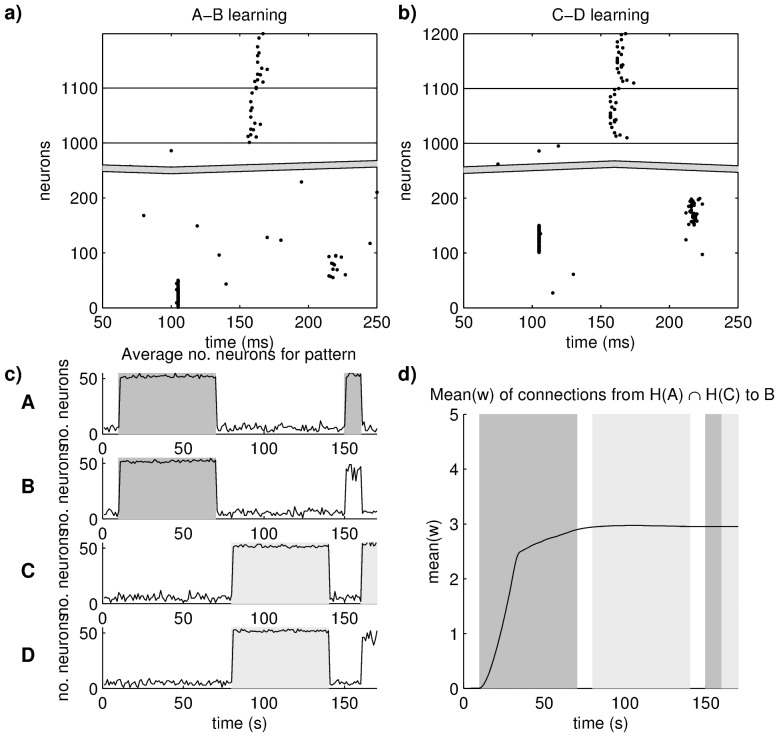
Pattern association through a hippocampal loop.Panel a) and b) show the recall of two previously learned associations. Both recalls were initiated by an external cue at around 100 ms, which evoked a sparse temporal pattern in the hippocampal layers, which in turn drove the target pattern in the cortex. c) Average number of neurons for all four patterns during learning and recall. Grey bars indicate when patterns have been externally stimulated. d) Mean weight for connections between hippocampal neurons that spike in response to pattern A and C (H(A) and H(C), respectively) to target patterns B. Grey bars as in c). During the first learning phase, the connection weight increase and thereby contribute to the association of pattern A with B. Although in the second learning phase the same hippocampal neurons are also activated by pattern C, their connections to neurons of pattern B remain stable indicating that the spatio-temporal sequence of hippcampal neurons is important for storing unique associations.